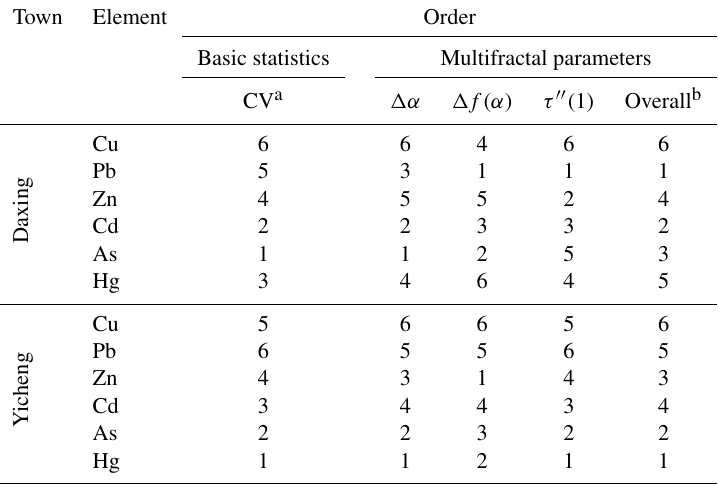
Table 3. Elements sorted by multifractal parameters and basic statistic indices. Town Element Order Basic statistics